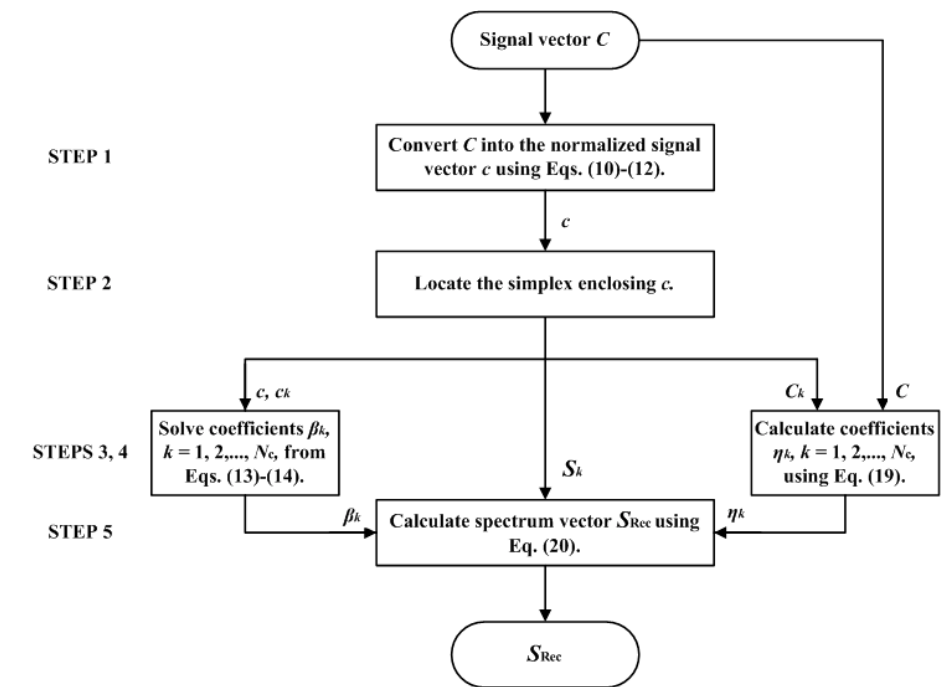
Figure 3. Flow chart to interpolate the test sample using the II-LUT method.